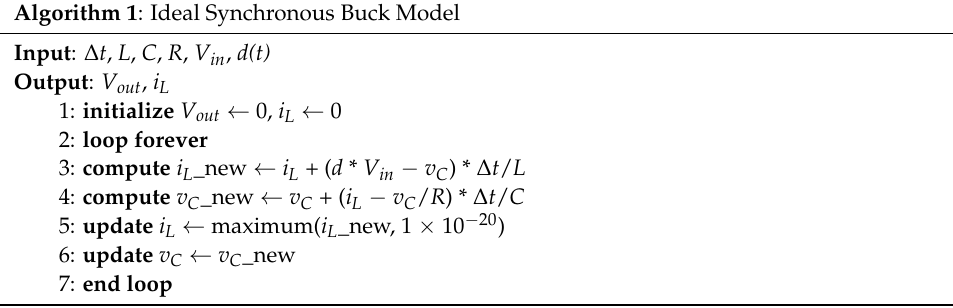
Algorithm 1 : Ideal Synchronous Buck Model